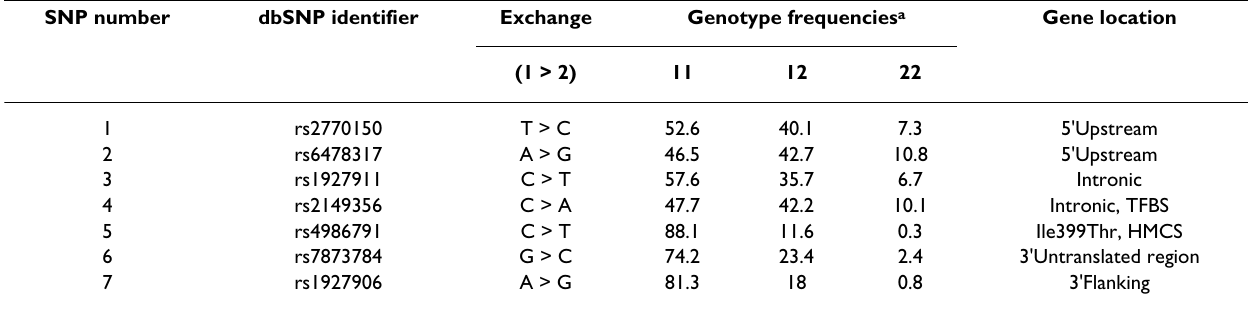
Table 2: Description of TLR4 variants genotyped (n = 1,968). SNP number